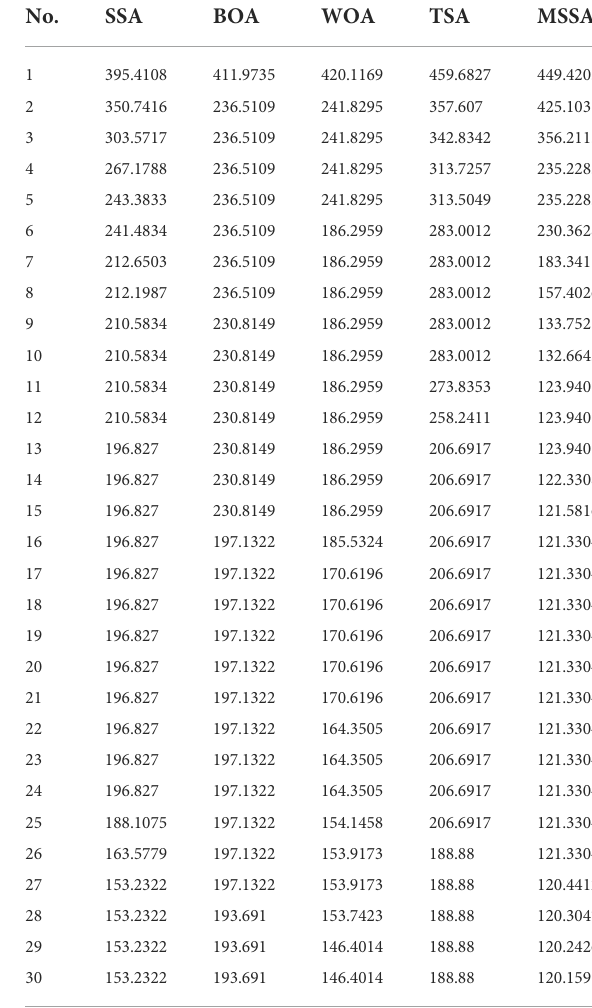
Figure 7. Convergence curve experiment The trajectory simulation results of the two mission